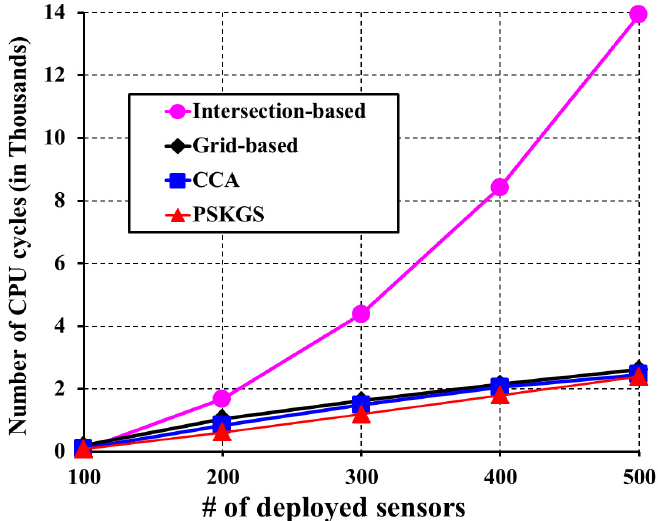
Figure 11. The performance comparison of the intersection-based [4], grid-based [5], CCA [31] and proposed PSKGS with respect to the computational cost for K =